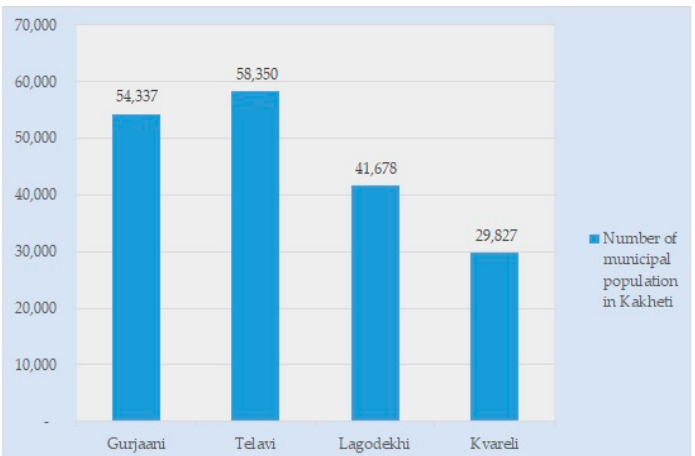
Figure 4. Distribution of family holdings in targeted municipalities of Kakheti (source: Geostat, cen- sus 2014).